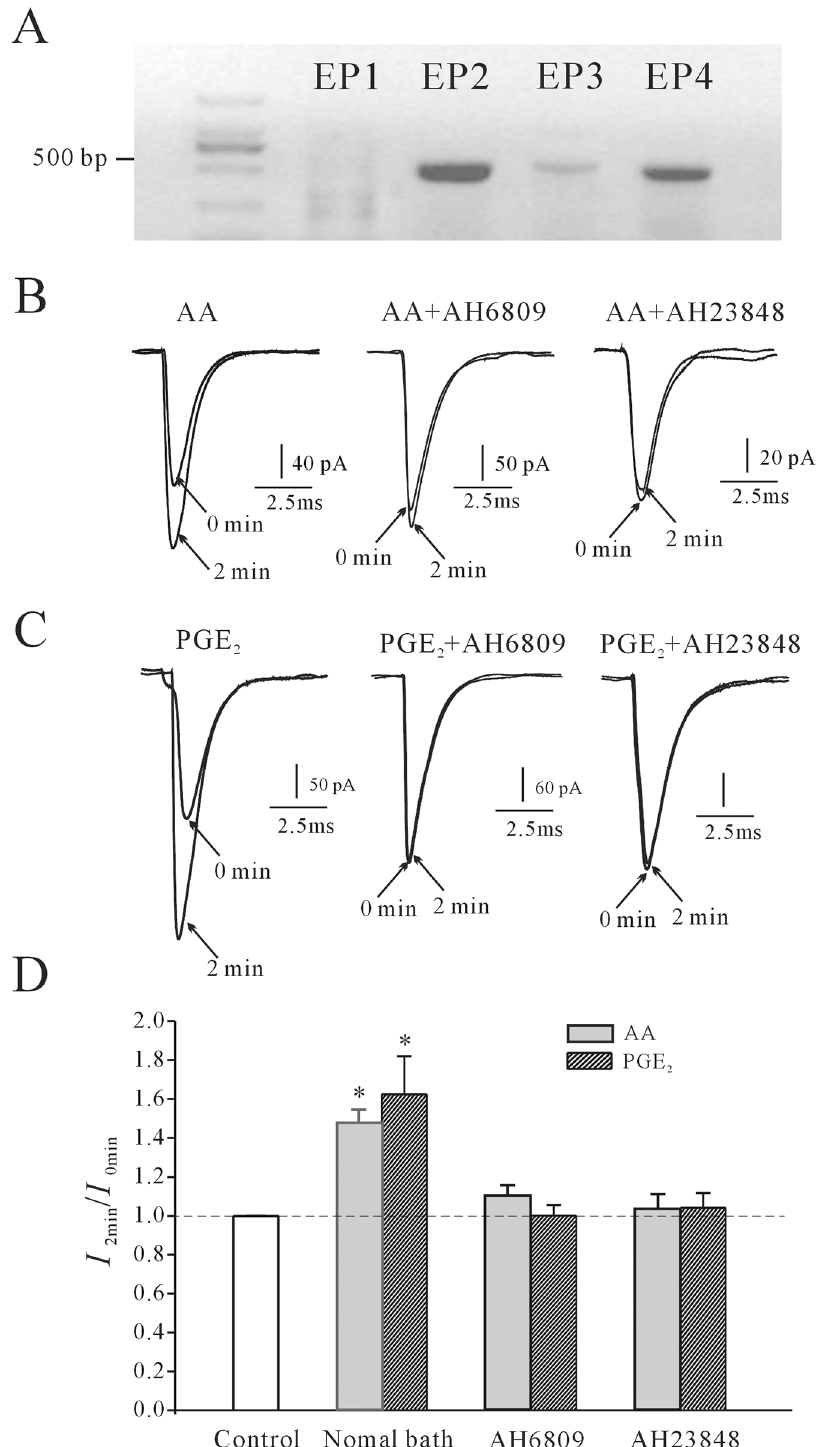
Fig 7. The effects of EP2/EP4 receptor antagonists on AA/PGE 2 -induced increases in rNa V 1.4 current. (A) RT-PCR analysis shows the presence of EP receptor mRNA in HEK 293 cells. (B) rNa V 1.4 current traces taken at the initial time point (0 min, at membrane rupture) and after intracellular application of AA in the absence or presence of 25 μ M AH6809 or AH23848 for 2 min. (C) rNa V 1.4 current traces taken at the initial time point (0 min, at membrane rupture) and after internal infusion of PGE 2 in the absence or presence